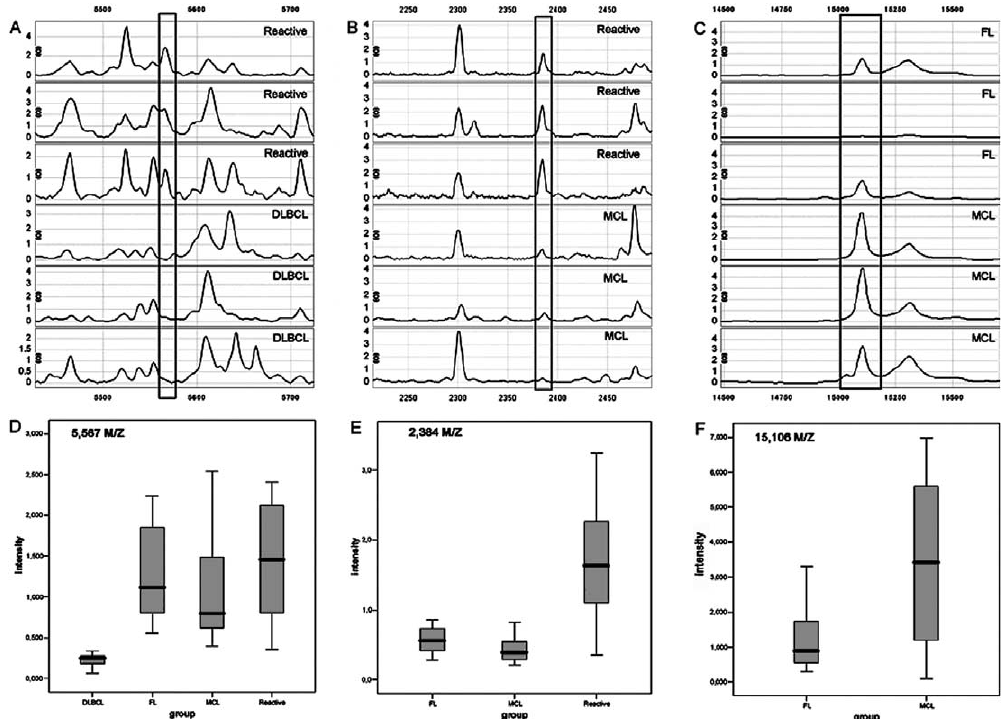
Fig. 3. SELDI-TOF MS enables detection of differentially expressed proteins in lymphoma tissue samples. Examples of three differentially expressed peaks are shown in panels A–C. A small peak at M/Z 5,567 is detected in reactive benign nodes, FL and MCL but is absent in cases of DLBCL ( p –value < 0.00002) (Fig. 3A). Similarly, a peak at M/Z 2,384 is expressed in benign reactive nodes, but this peak is almost absent in the spectra of MCL and FL cases ( p -value < 0.0002) (Fig. 3B). A third example of a peak at M/Z 15,106 shows a differential expression, however the difference is not significant ( p -value = 0.12) (Fig. 3C). The lower panels (Fig. 3D–E) show the corresponding box-whisker plots for the mean intensities (Y-axis) of the peaks at M/Z 5,567, 2,384 and 15,106 respectively. The different groups are plotted along the